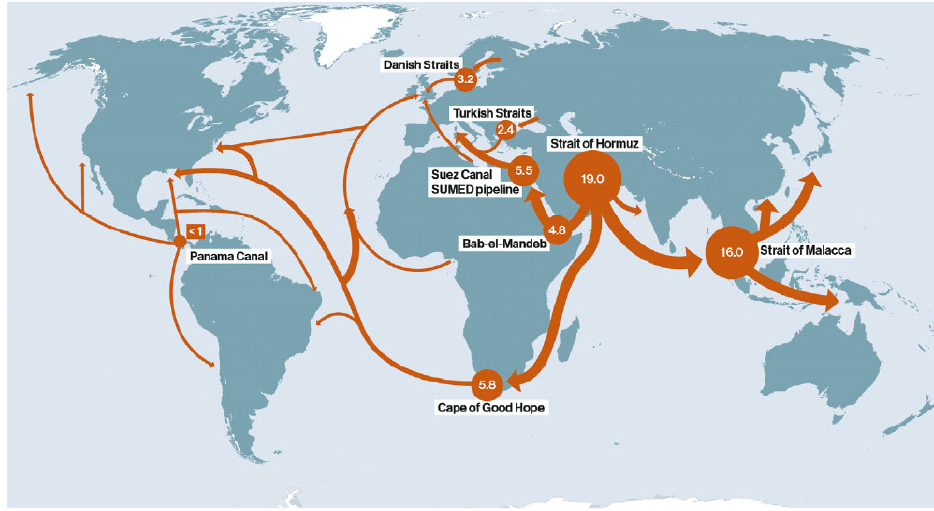
Figure 1. Strategic oil transfer straits [15].